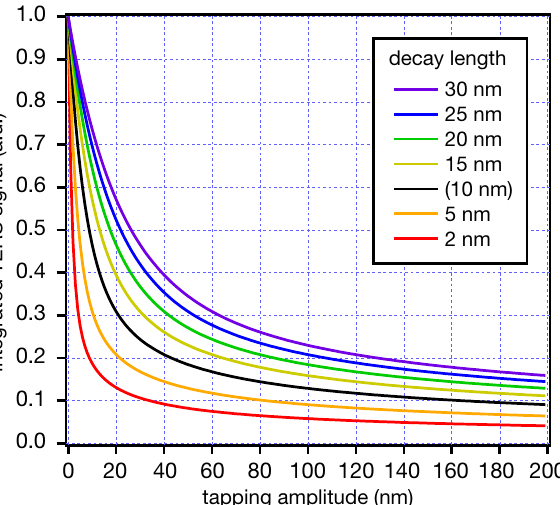
Figure 3. Relationship between integrated TERS signal and the tapping amplitude at different decay lengths of TERS intensity.